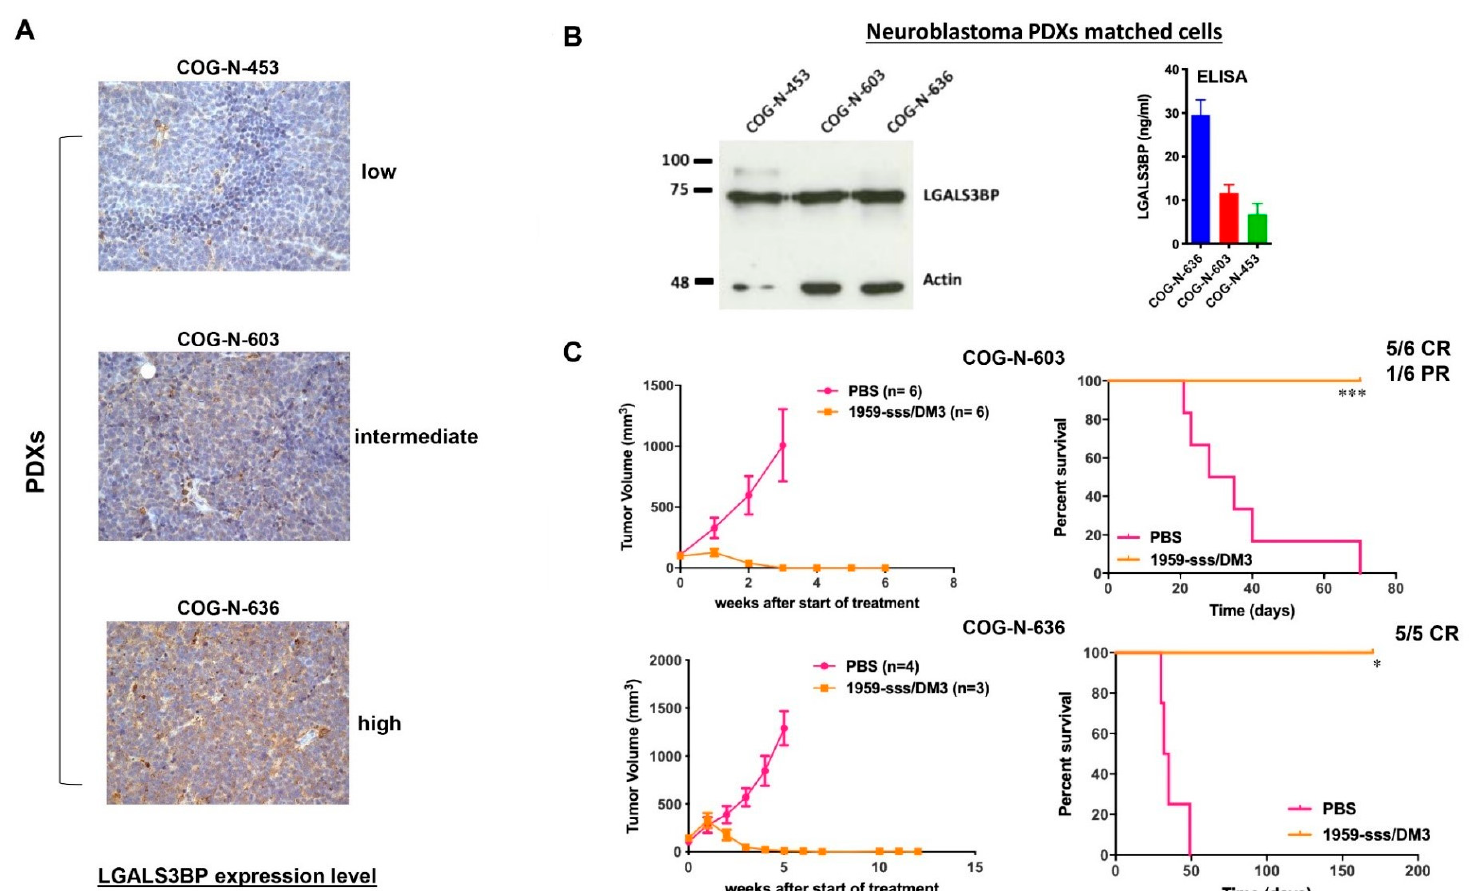
Figure 4. 1959-sss / DM3 induces tumor shrinkage in neuroblastoma PDX models. ( A ) LGALS3BP expression was evaluated by IHC in three neuroblastoma PDXs by IHC and in matched cell lines ( B ) by WB and ELISA. ( C ) Subcutaneous COG-N-603 and COG-N-636 PDXs growth curves of intravenous 1959-sss / DM3 administration at the dose of 10 mg / kg twice weekly for 4 doses. Survival curves were evaluated by Kaplan-Meier and analyzed by the log-rank test using Graphpad Prism 5 software. * p = 0.01; *** p = 0.0005. CR: complete remission; PR: partial response.